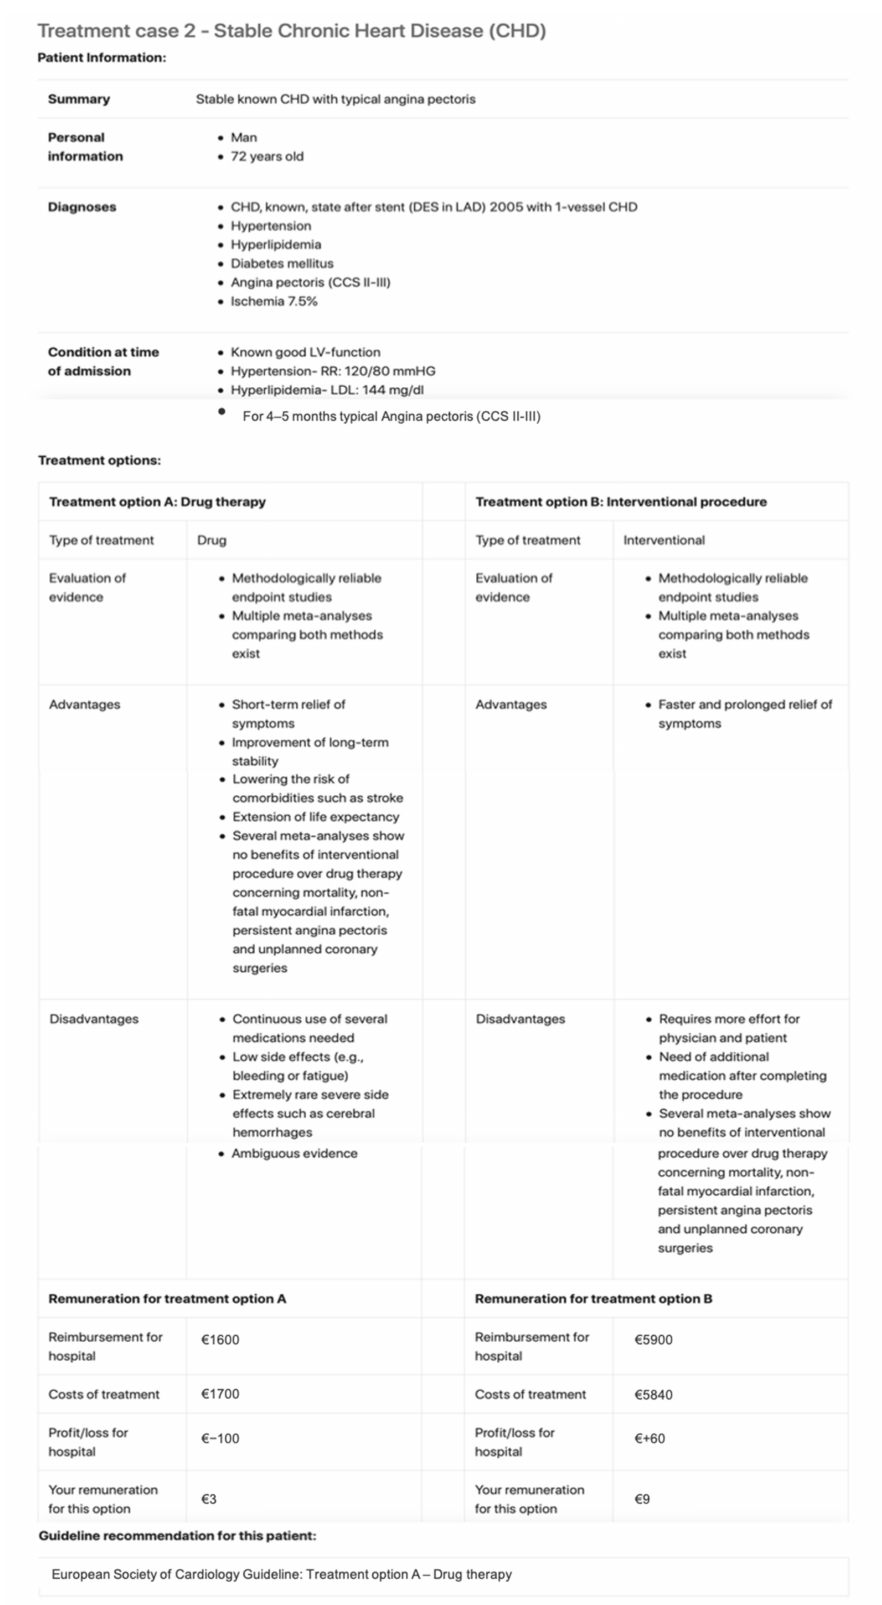
Figure 1. Example of stylized routine